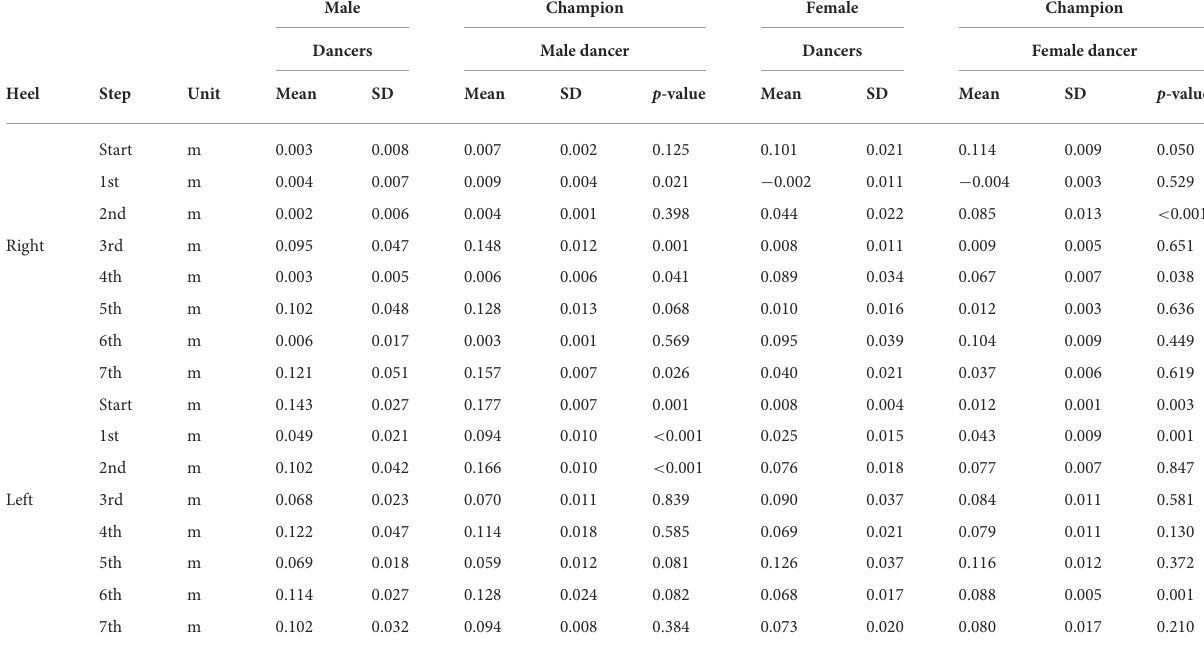
TABLE 2 Left and right heel heights at the timing of each step of the champion male and female dancers and the control group male and female dancers during the spin movement. Male Champion Female Champion Dancers Male dancer Dancers Female